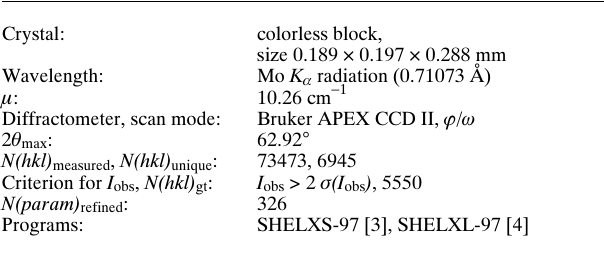
Table 1. Data collection and